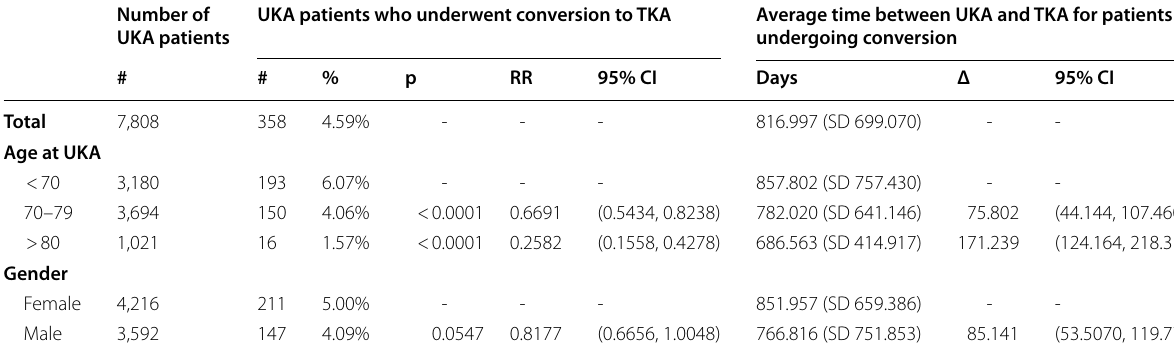
Table 4 Time between UKA and TKA for patients undergoing conversion Number of UKA patients who underwent conversion to TKA Average time between UKA and TKA for patients UKA patients